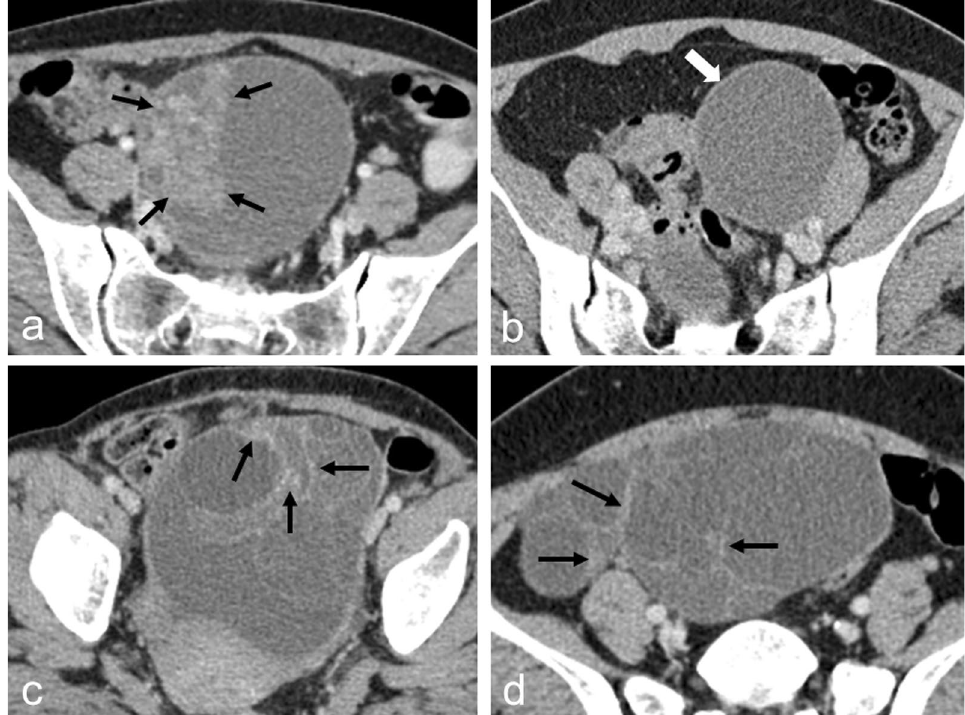
Fig. 5 Contrast‑enhanced CT images of ovarian tumors that were misclassified by AI model or/and junior radiologists. a A malignant ovarian tumor (clear cell carcinoma) that was predicted to be benign by AI model but malignant by all junior radiologists. The solid portion (arrow) in the tumor is a clue for malignancy in radiological evaluation. b A benign ovarian tumor (endometrioma) that was predicted to be malignant by AI model but benign by all junior radiologists. There was no solid portion, mural nodule, or thick septa to indicate malignancy in radiological evaluation. c A benign ovarian tumor (mucinous cystadenoma) that was predicted to be malignant by both AI model and all junior radiologists. d A benign ovarian tumor (mucinous cystadenoma) that was predicted to be malignant by all junior radiologists but benign by AI model. Thick septa (arrow) in c and d raised the suspicion of malignancy in radiological